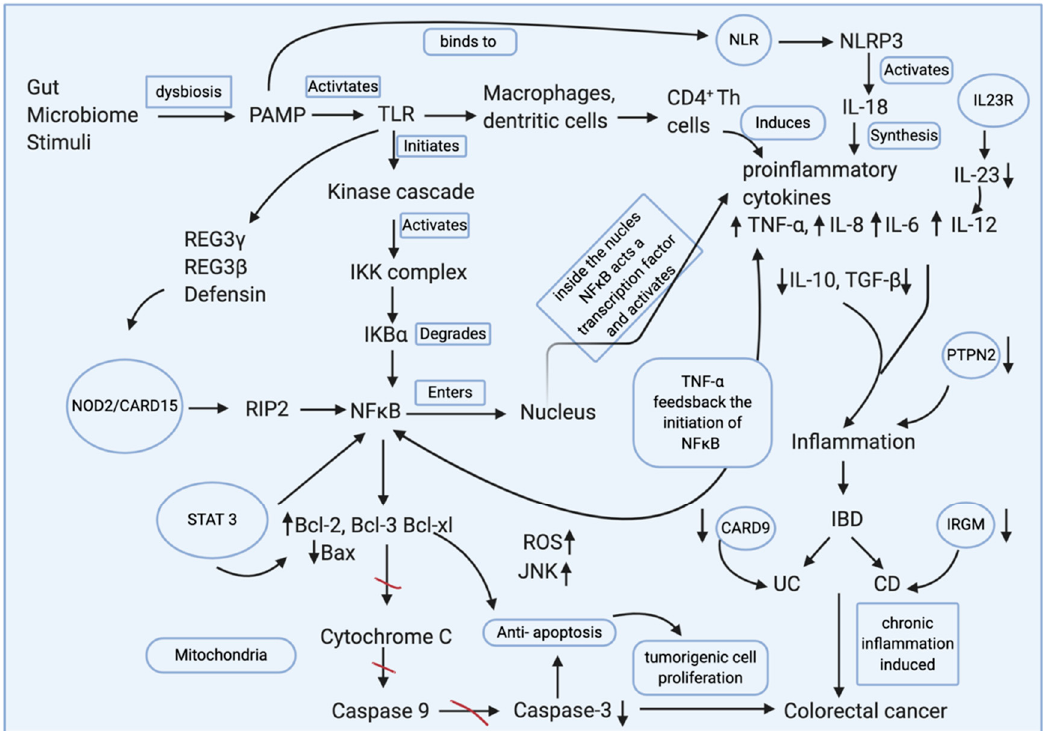
Figure 2. Various gut microbial stimuli due to dysbiosis can cause the initiation of inflammation in the intestine. The release of the proinflammatory cytokines inducing inflammation through various pathways assures the destruction of pathogenic microbes, and homeostasis is maintained when the resolution phase is used for controlling the inflammation and damage repair. Dysbiosis, combined with genetic defects, can omit the resolution phase with continuous chronic inflammation leading to the introduction of IBD. The pathogen-associated molecular pattern (PAMP) releases can activate the Toll-like receptors (TLRs) to initiate the regenerating islet-derived protein (REG)3 γ , REG3 β , and defensin that promotes the nucleotide-binding oligomerization domain-containing protein (NOD2) to release nuclear factor kappa B (NF κ B). A PAMP-activated TLR can also instigate the canonical pathway for the release of NF κ B through the activation of the kinase cascade that in turn activates the IKB kinase